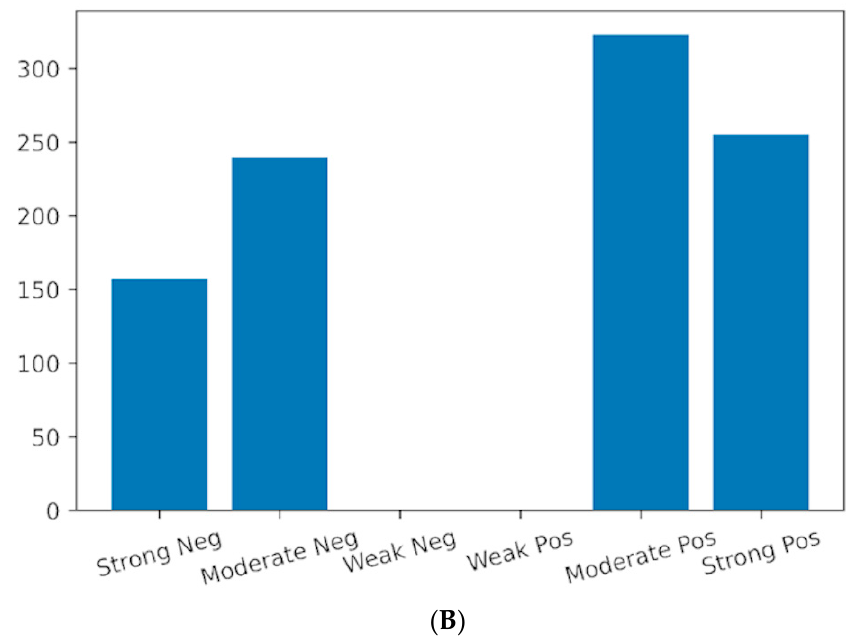
Figure 3. ( A ) Correlation map of radiomic features. Shown is a color-coded correlation map between all the radiomic features. Only statistically significant ( p < 0.05) correlations are displayed. The color coding was based on the Spearman ± ρ values: strong (0.7 to 1.0), moderate (0.3 to 0.7), weak (0 to 0.3), and indicated as positive (pos) or negative (neg). ( B ) Radiomic feature correlation histogram. Histogram demonstrating the counts of each type of significant correlation.